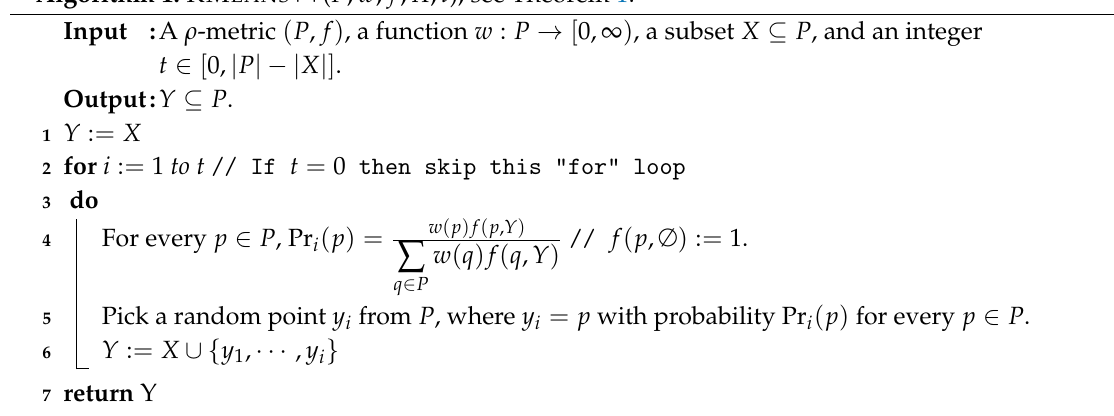
Algorithm 1: KM EANS ++( P , w , f , X , t ); see Theorem